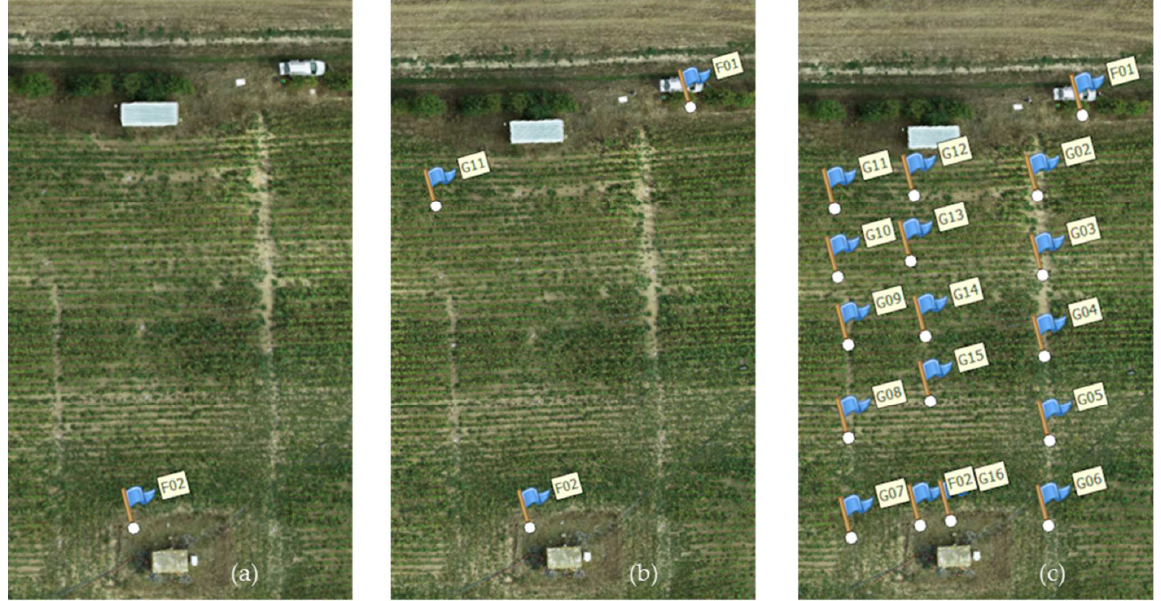
Figure 21. Location of GCPs used as control points for alignment in Metashape: ( a ) 1 GCP for reconstruction R_1_1gcp; ( b ) 3 GCPS for reconstruction R_1_3gcp; ( c ) 17 GCPs for reconstruction R_1_17gcp.